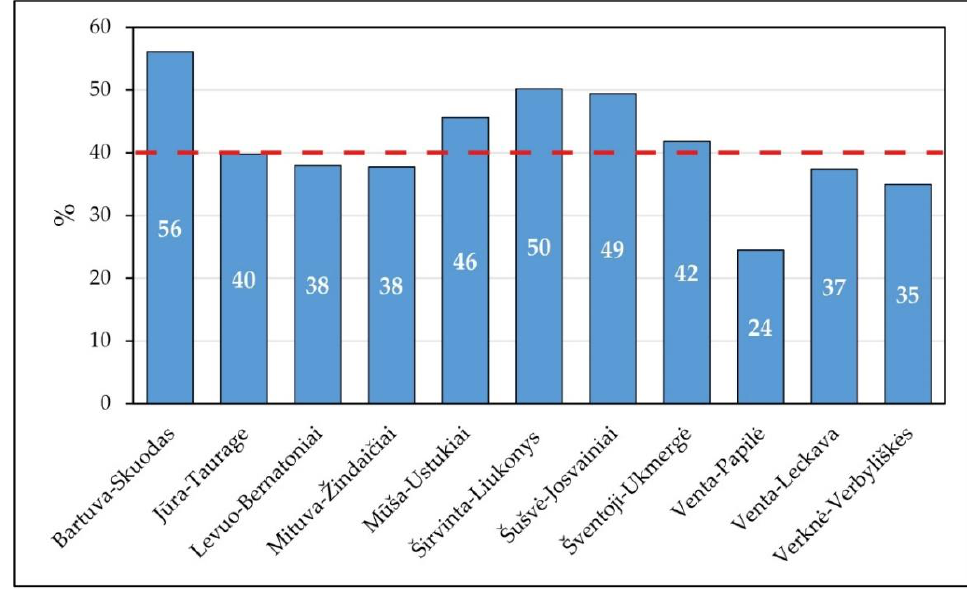
Figure 12. The overall degree (%) of hydrologic alterations.